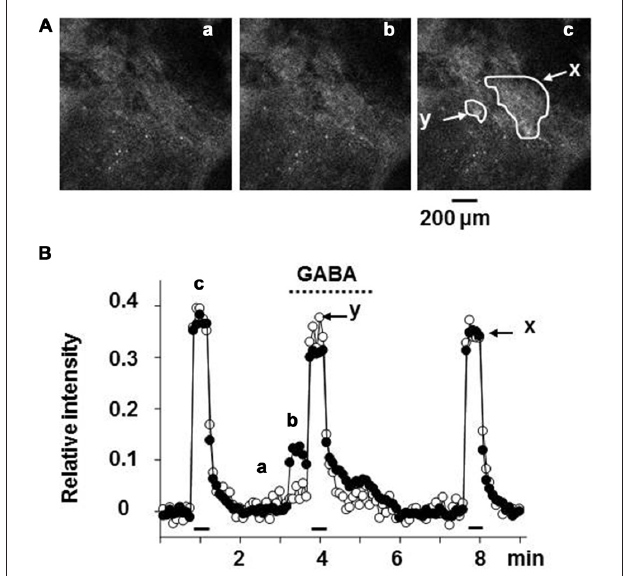
FIGURE 3 | Suppression of the synaptically evoked Ca 2 + signal in rat adrenal chromaffin cells by GABA. (A) Confocal images of Fluo-4 fluorescence in rat adrenal medulla. The adrenal gland was retrogradely loaded with Fluo-4 AM, a Ca 2 + indicator via the adrenal vein, and then part of the adrenal cortex covering the medulla was removed by microscissors under a stereoscope (Warashina and Inoue, 2012). The adrenal gland was placed between a pair of silver circles for electrical stimulation. Confocal images of FITC-like fluorescence in adrenal chromaffin cells were acquired every 5 s. (B) Relative values of the change in fluorescence intensity are plotted against time. The adrenal gland was retrogradely perfused with saline via the adrenal vein, and 30 µ M GABA was added to the perfusion solution during the indicated period (dotted line). Nerve fibers were electrically stimulated with 60 V pulses of 1.5 ms duration at 10 Hz for 30 s (bars). Fluorescence intensities in the areas ( x and y ) indicated in (A) part c were measured and presented as filled ( x ) and open ( y ) symbols, respectively. Note that the cells in the region indicated by y showed no response to the application of GABA, whereas those in the region marked x did. After correction for the decline due to photobleaching, the increase in fluorescence intensity was expressed as a fraction of the resting level. The images marked a, b, and c in (A) correspond to the points labeled in (B) . (A,B) Are reproduced from Matsuoka et al.